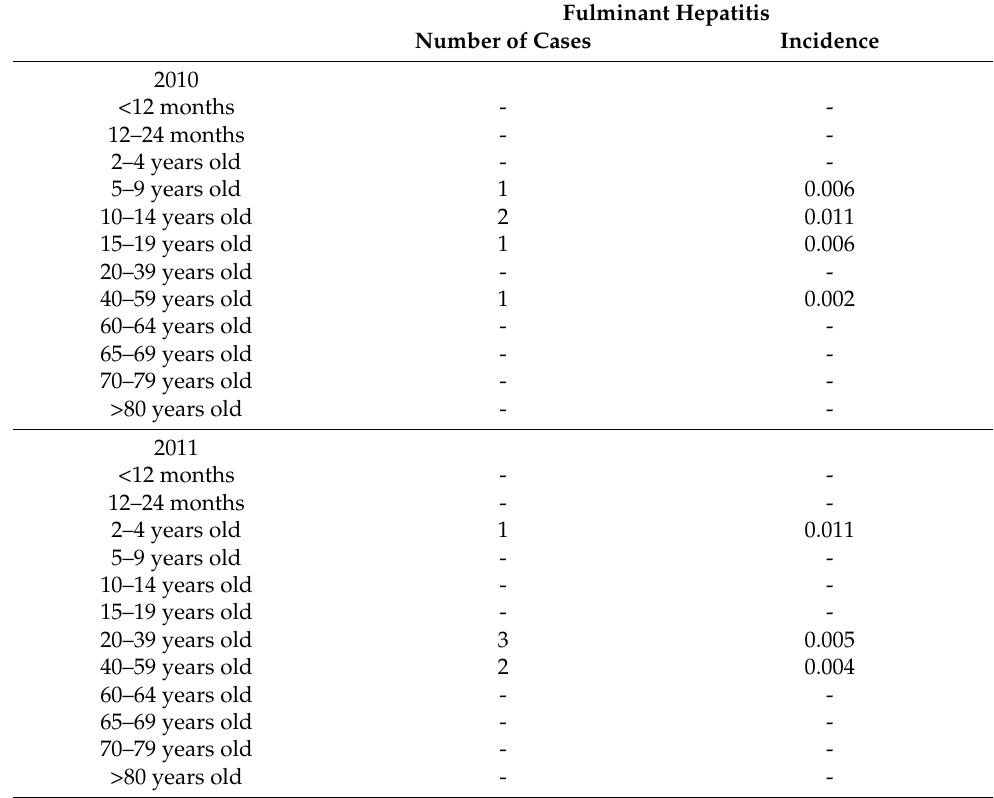
Table A2. Number of fulminant hepatitis cases reported between 2010 and 2018 according to age